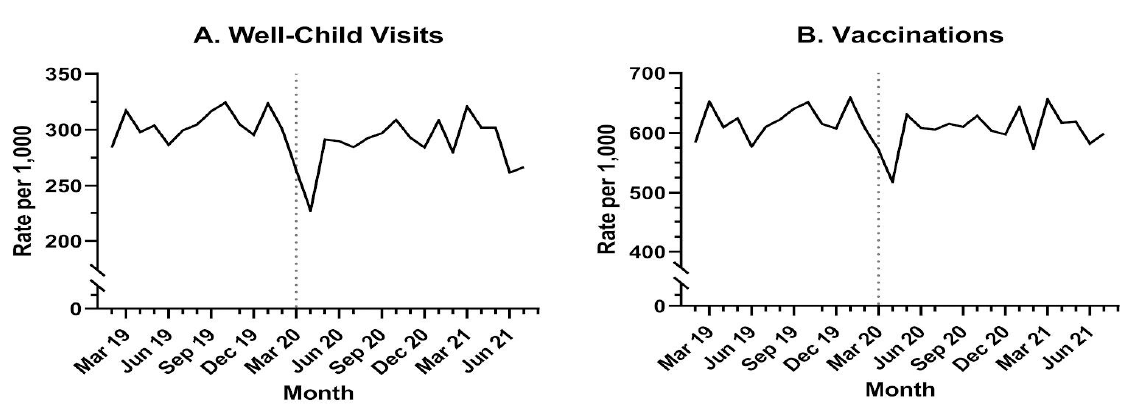
Figure 1. Well-Child Visit and Vaccination Rates: ( A ) Rates of well-child visits are reported per 1000 enrollees under 24 months of age; ( B ) rates of vaccination are reported per 1000 enrollees under 24 months of age.